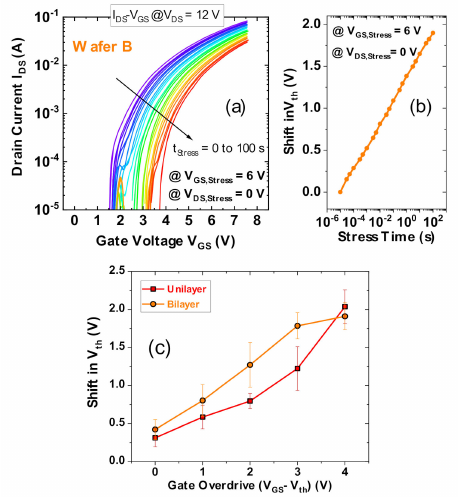
Figure 15. V th shift comparison from V th transient measurements between wafers for V GS stress voltages up to 4 V of overdrive. ( a ) displays a typically obtained set of 22 I D –V GS curves during 100 s of stress at V GS,Stress = 6 V and V DS,Stress = 0 V on a Wafer B device; the associated V th shift is plotted in ( b ). Averaged V th shifts (at 100 s) for 6 devices each, are plotted in ( c ) for V GS,Stress = 0 to 7 V for Wafer B with V th ≈ 3 V and V GS,Stress = 0 to 8 V for Wafer M with V th ≈ 4